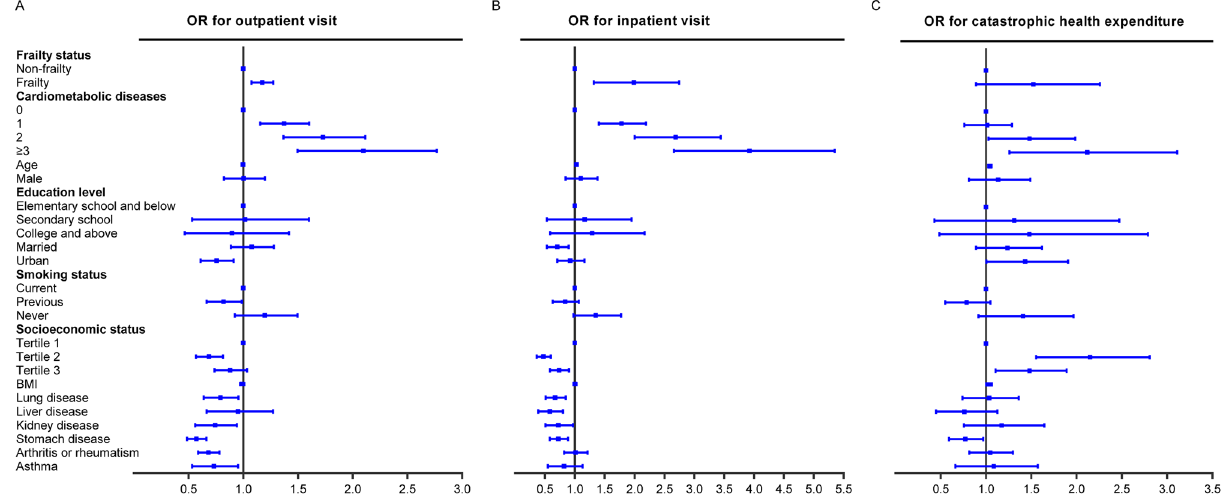
Figure 2. The association between cardiometabolic diseases, healthcare utilization and catastrophic health expenditure. Forest plots describing the associations of cardiometabolic diseases with ( A ) outpatient visit, ( B ) inpatient visit, and ( C ) catastrophic health